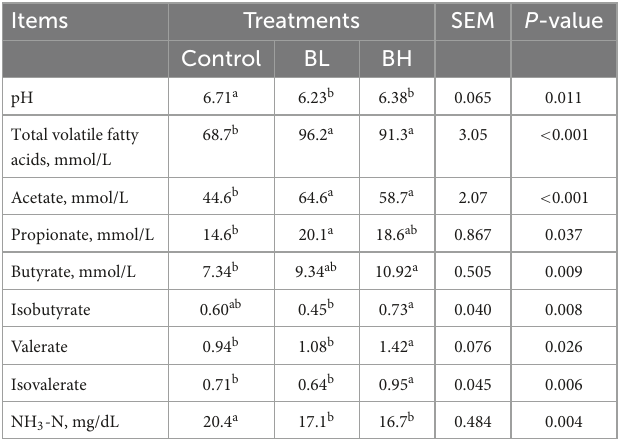
TABLE 3 Effects of biochanin A on rumen fermentation of dairy goats.